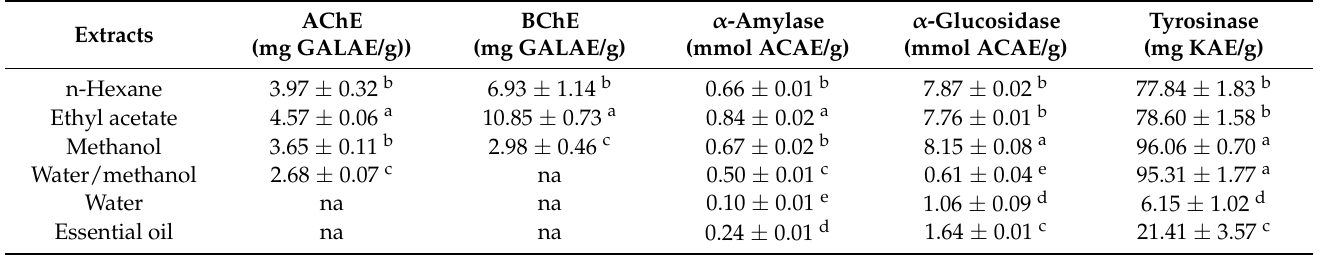
Table 7. Enzyme inhibitory effects of the tested